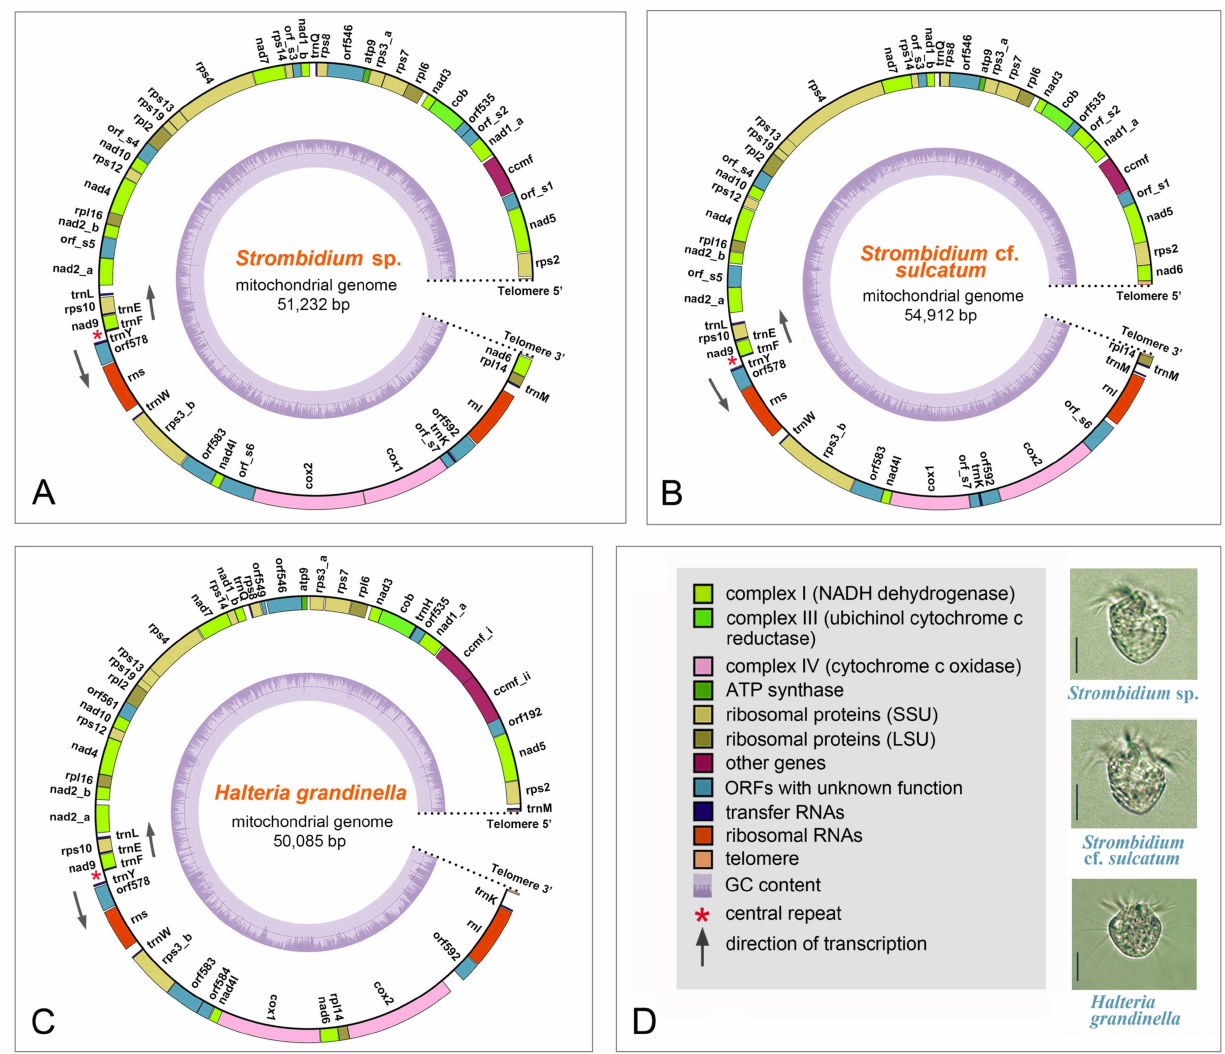
Figure 1. Mitochondrial and morphological information of the three species with newly characterized mitogenomes. ( A ) Mitogenome map of Strombidium sp. ( B ) Mitogenome map of Strombidium cf. sulcatum . ( C ) Mitogenome map of Halteria grandinella . ( D ) Photomicrographs of the three species in vivo and the legend of mitochondrial maps. Genes are represented by different colored blocks as indicated in the legend of diagram D. Outside and inside blocks of each mitochondrial map indicate the genes on the positive and reverse strands,